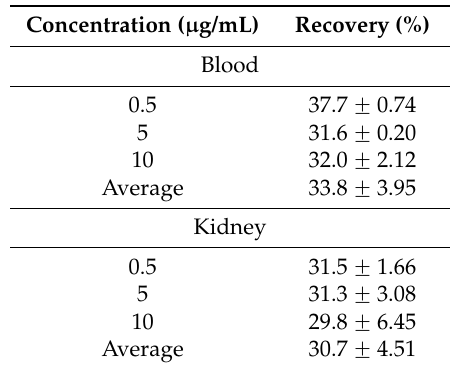
Table 2. In vivo microdialysis recovery (%) of maleic acid in rat blood and